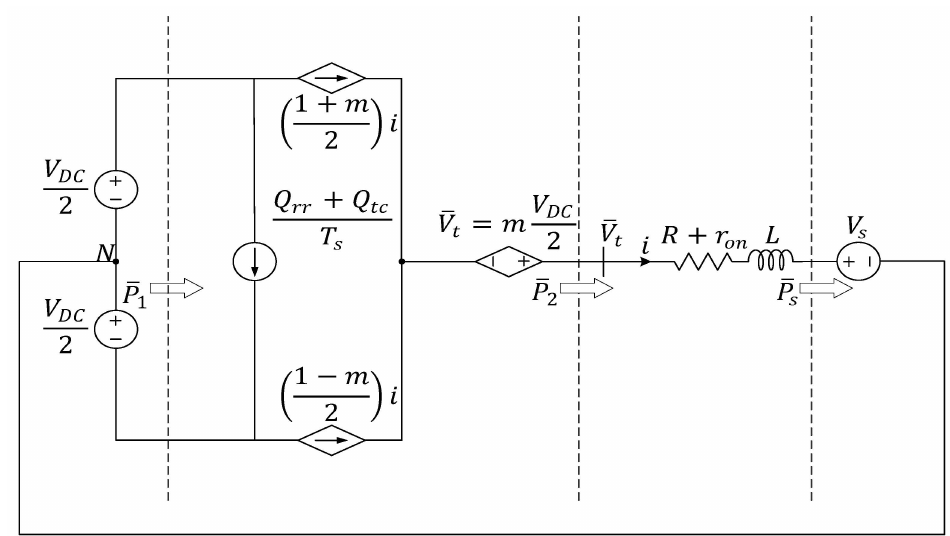
Figure 17. Simplified nonideal half-bridge converter average equivalent circuit.